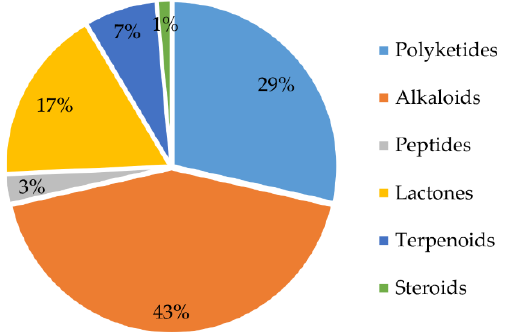
Figure 13. Structural types of compounds isolated from Chrysosporium from 1984 to 2021.